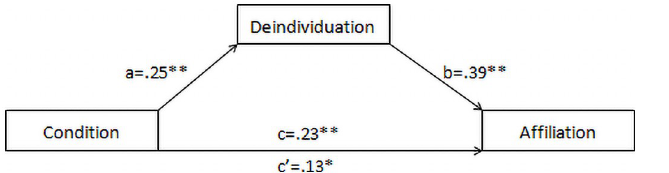
Fig 1. Effect of imagined movement condition on affiliation. � p < .05, �� p < .001.